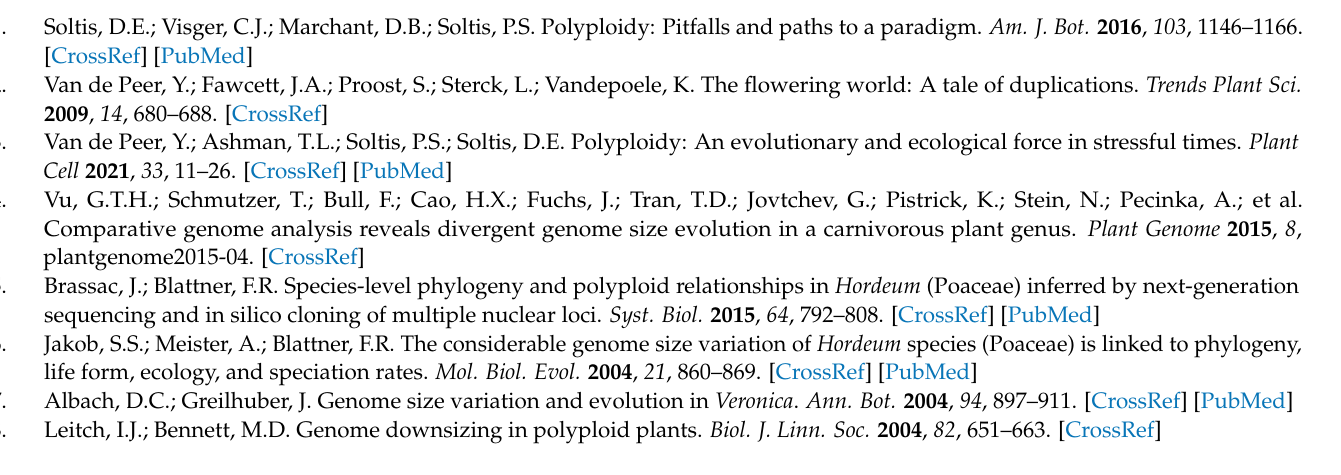
Table S4: The dataset for morpho-anatomical analyses (consisting of the parental diploid species C. vernus and C. heuffelianus and all polyploid cytotypes of C. cf. heuffelianus ); Table S5: Information on GBS data, loci, and heterozygosity in Crocus ser. Verni .; Table S6: Fixation index (F st ) of allotetraploids versus diploids in Crocus ser. Verni ; Table S7: The differential characters based on representative populations dataset of Crocus ser. Verni highlighted by the principal component analysis (PCA); Table S8: Discriminant analysis (CDA) conducted on the dataset including all populations of diploid accessions of C. vernus and C. heuffelianus and all polyploid accessions of C. cf. heuffelianus ; Dataset S1: Alignment of concatenated GBS loci used for phylogenetic analysis; Dataset S2: Variant calling format (vcf) file of the series Verni dataset used for FAST S TRUCTURE and LEA; Dataset S3: Unlinked SNP matrix in .geno format used for PCA. Dataset S4: RAD PAINTER input file. References [72,73] are cited in Supplementary